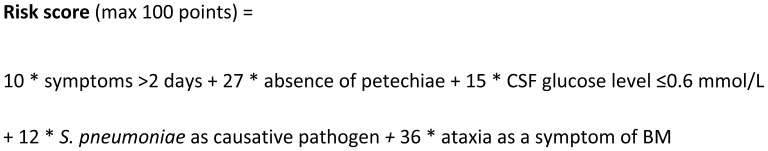
clinical prediction rule for the prediction of hearing loss after childhood BM, as presented by Koomen et al.